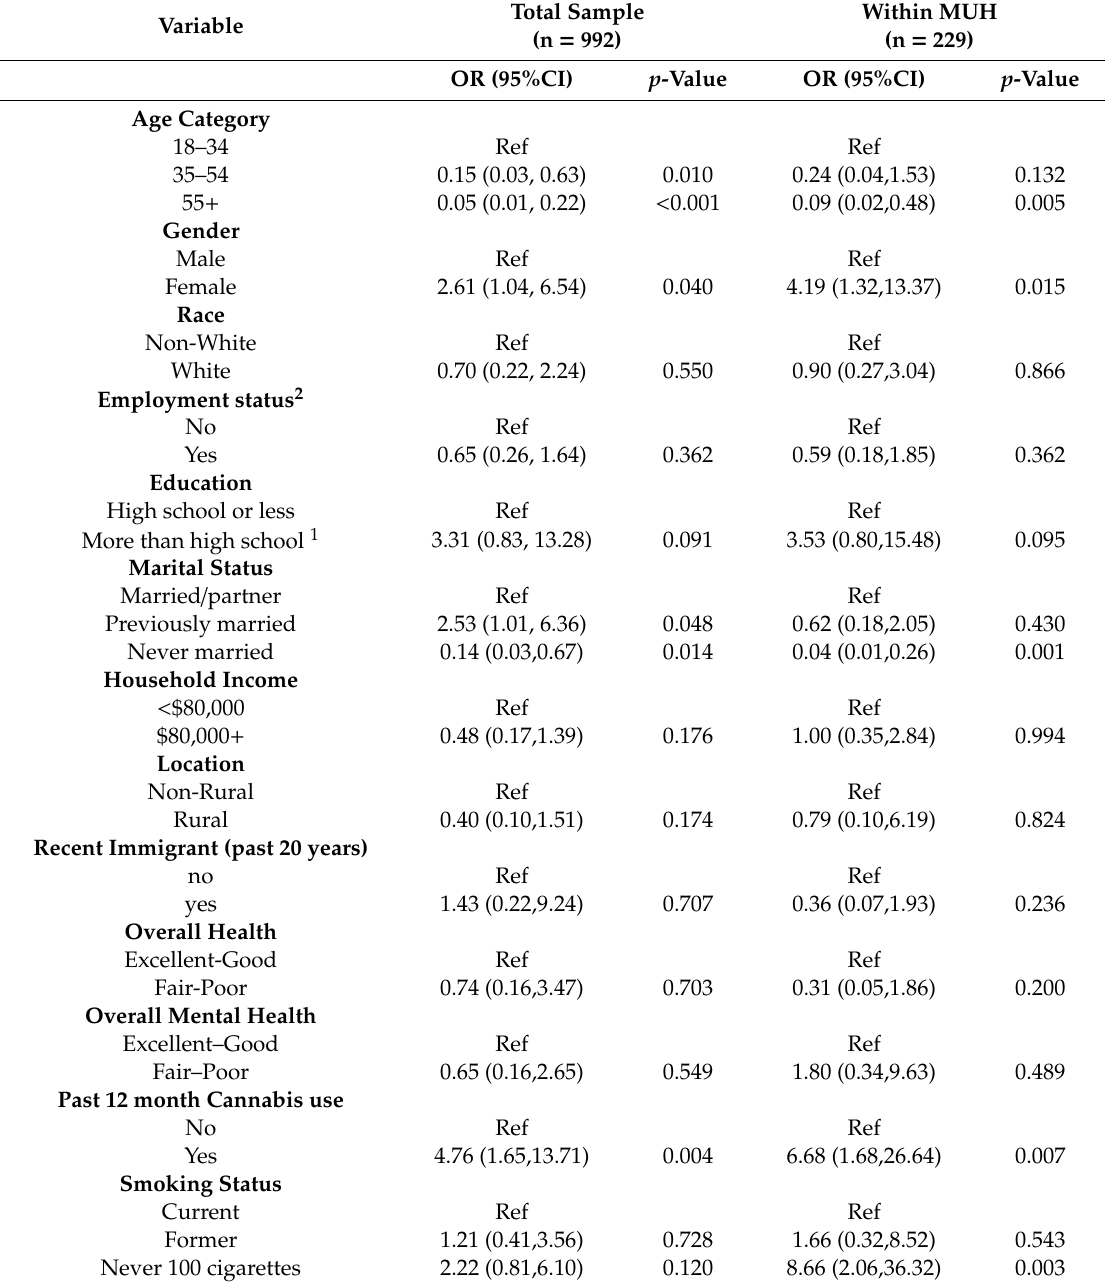
Table 3. Odds Ratios of Exposure to Environmental Tobacco Smoke Versus Non-exposed Individuals Living in Multi-Unit Housing, Ontario, Canada,